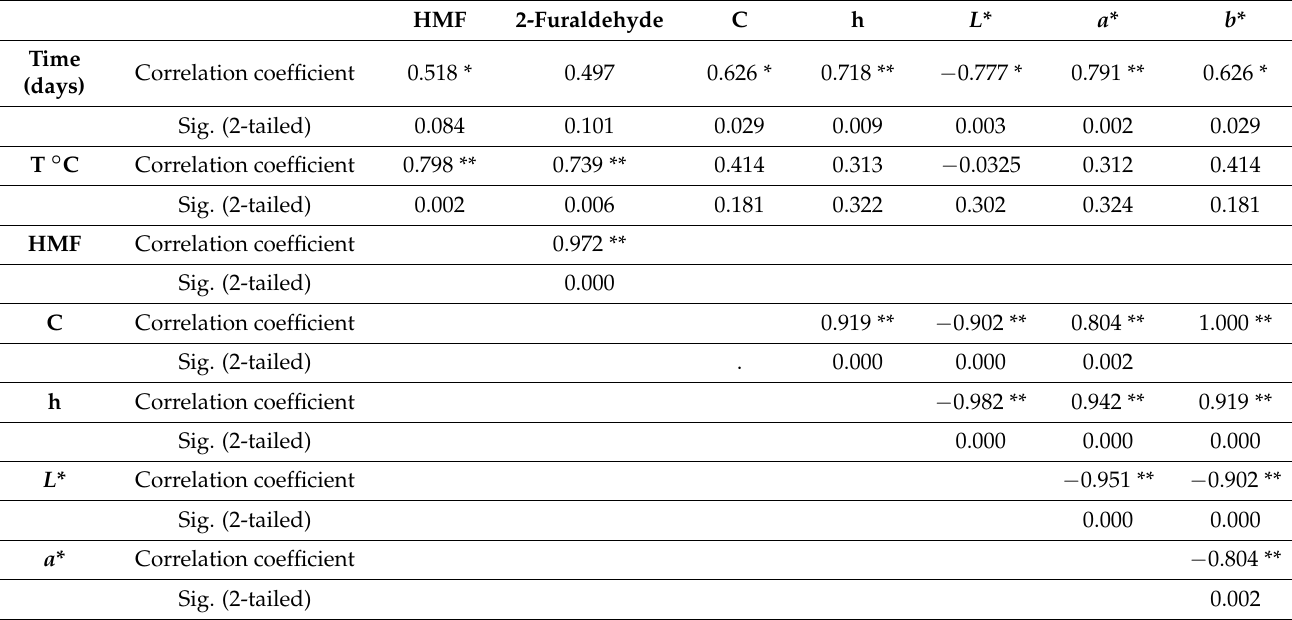
Table 6. Spearman’s rho T = 30-35-40 ◦ C from 90 to 180 days of storage ( N = 12). (HMF: 5-hydroxymethylfurfural; 2F: 2-furaldehyde: C: chroma; h: hue; L *: lightness; a *: redness; b *: yellowness).